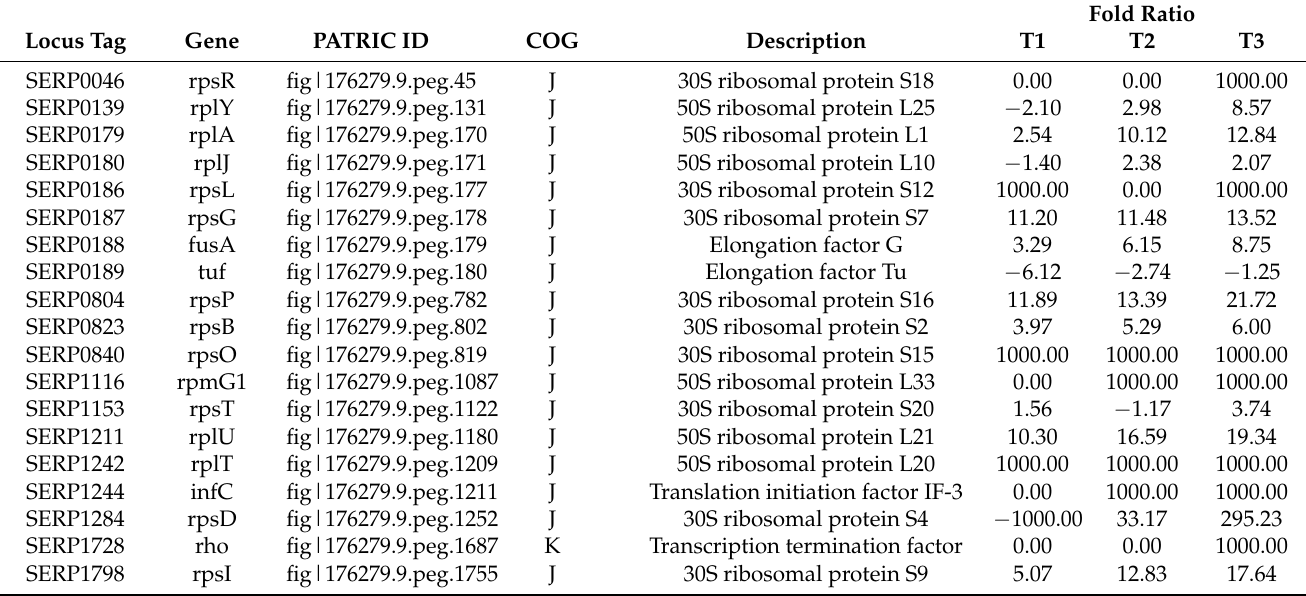
Table 9. Differentially expressed proteins associated with ribosome pathway.